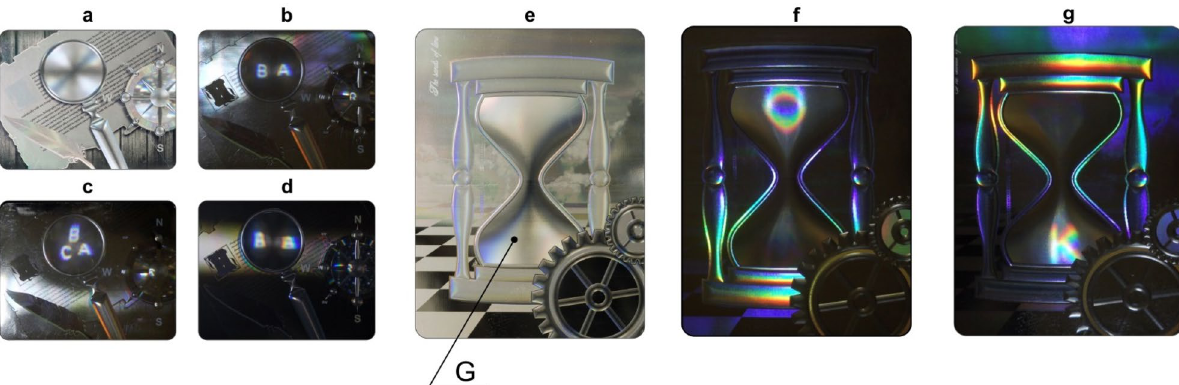
Figure 4. Photos of the manufactured DOEs. ( a ) Photo of a DOE (variant 1) taken in scattered light. ( b ) Photo of a DOE (variant 3) taken when illuminated by a point source (see Supplementary Video 1). ( c ) Photo of a DOE (variant 3) taken when illuminated by a point source (see Supplementary Video 2). ( d ) Photo of a DOE with a binary microrelief in variant 1 when the element is illuminated by a point source. ( e ) Photo of a DOE with an hourglass image when illuminated by scattered light. ( f , g ) Photos of a DOE taken at different tilt angles of the element when illuminated by a point source (see Supplementary Video